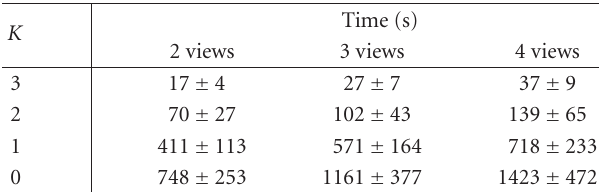
Table 3: Noncumulative time spent at each level K of a multiresolu- tion pyramid for the registration of the CT volume to pairs, triplets, and quadruplets of C-arm images of a single vertebra, in seconds on a Pentium III